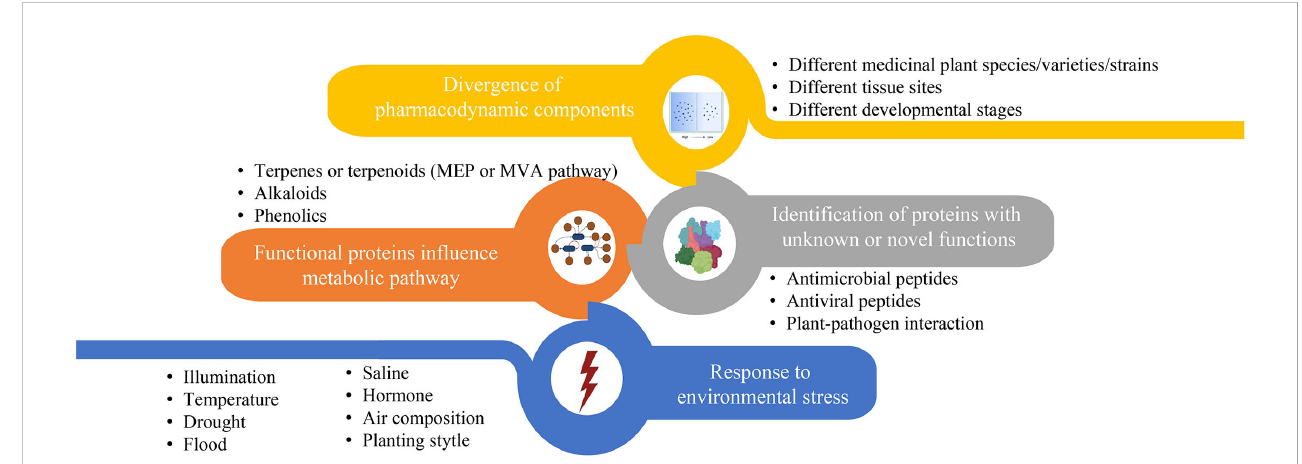
FIGURE 3 The main contents of proteome research related to biosynthesis or accumulation of metabolites in medicinal